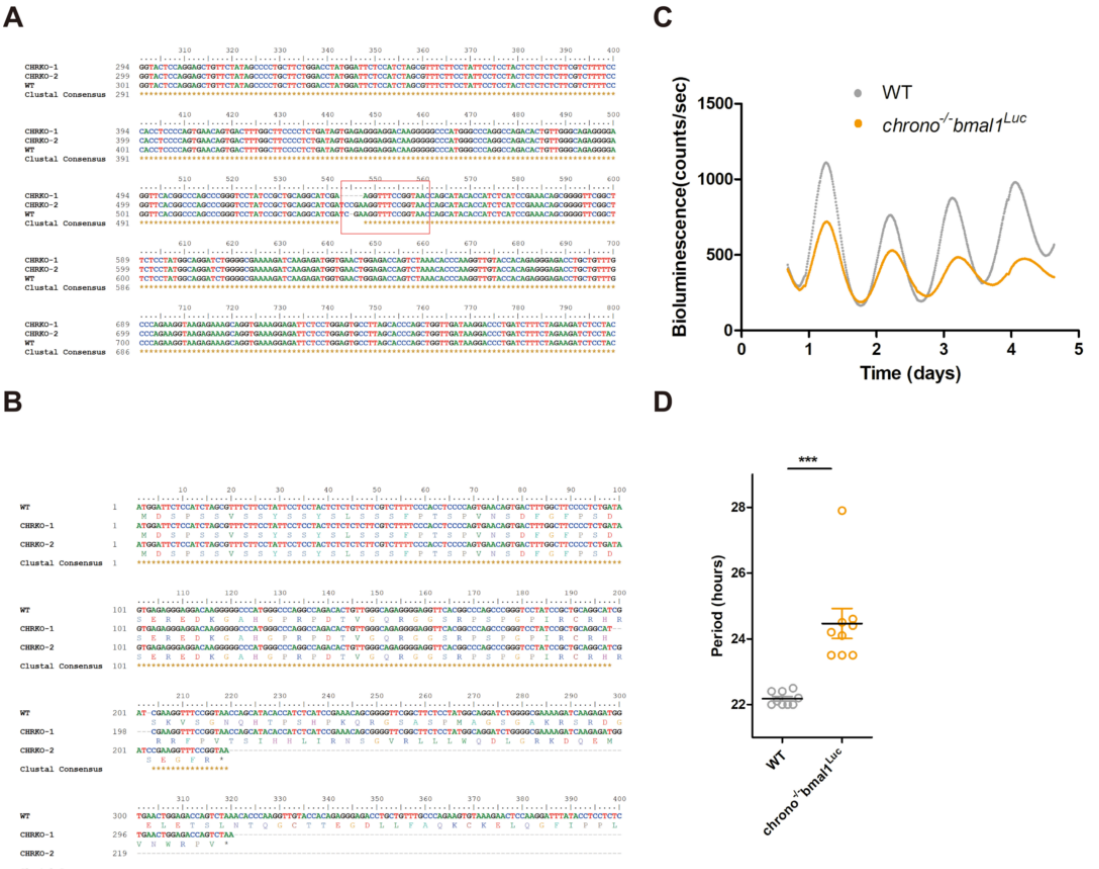
Figure 5. chrono deletion gives rise to longer period in U2-OS cell line. ( A ) Sequence alignment between wild-type and chrono -/- bmal1 Luc cells showed that the knockout cell line is heterozygous with four bases deleted in one allele and one base insertion in the other. ( B ) These indels caused early termination of translation through sequence analysis. Corresponding amino acid sequences are presented underneath the nucleotide sequences. Asterisk marksindicate the stop codons caused by the indels. ( C ) Representatives of raw bioluminescence data from U2-OS cells expressing BMAL1:dLUC reporter are plotted for both WT and chrono − / − bmal1 Luc cell lines. ( D ) Period measured by Lumi Cycleluminometer is plotted using nine repeats from each cell line. Graphpad Prism 5 was used to generate graphs/plots and perform statistical analysis (2-tailed unpaired t-test). *** p< 0.001.